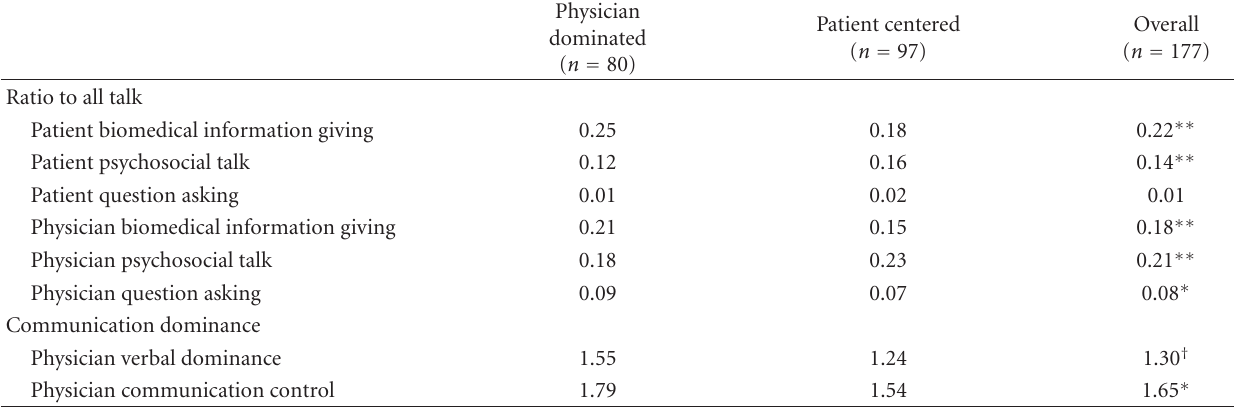
Table 1: Amount of talk in communication categories by style of doctor-patient interaction.